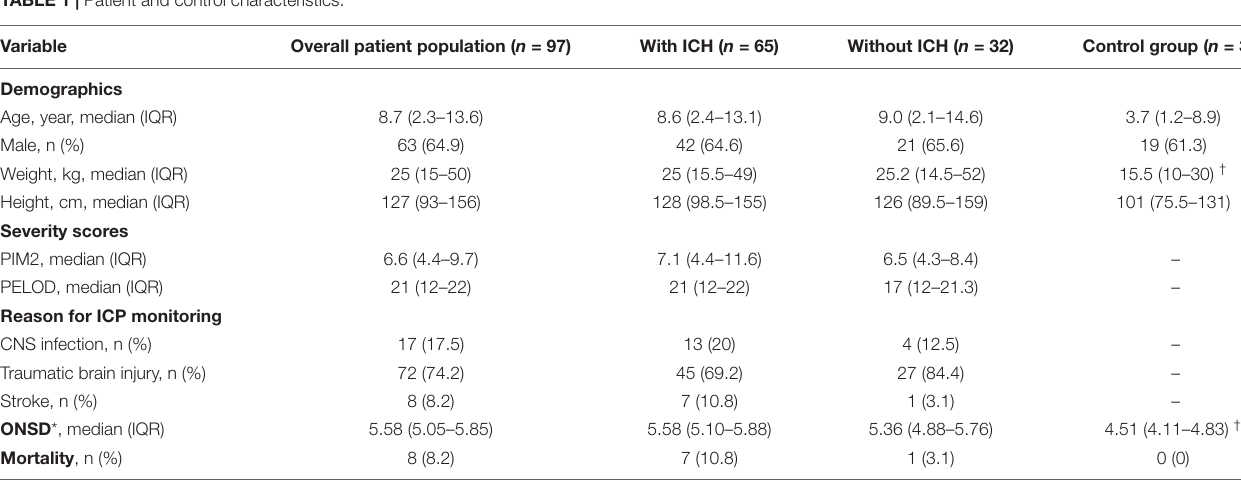
FIGURE 1 | Patients’ flow diagram. ONSD, Optic Nerve Sheath Diameter; ICP, intracranial pressure. TABLE 1 | Patient and control